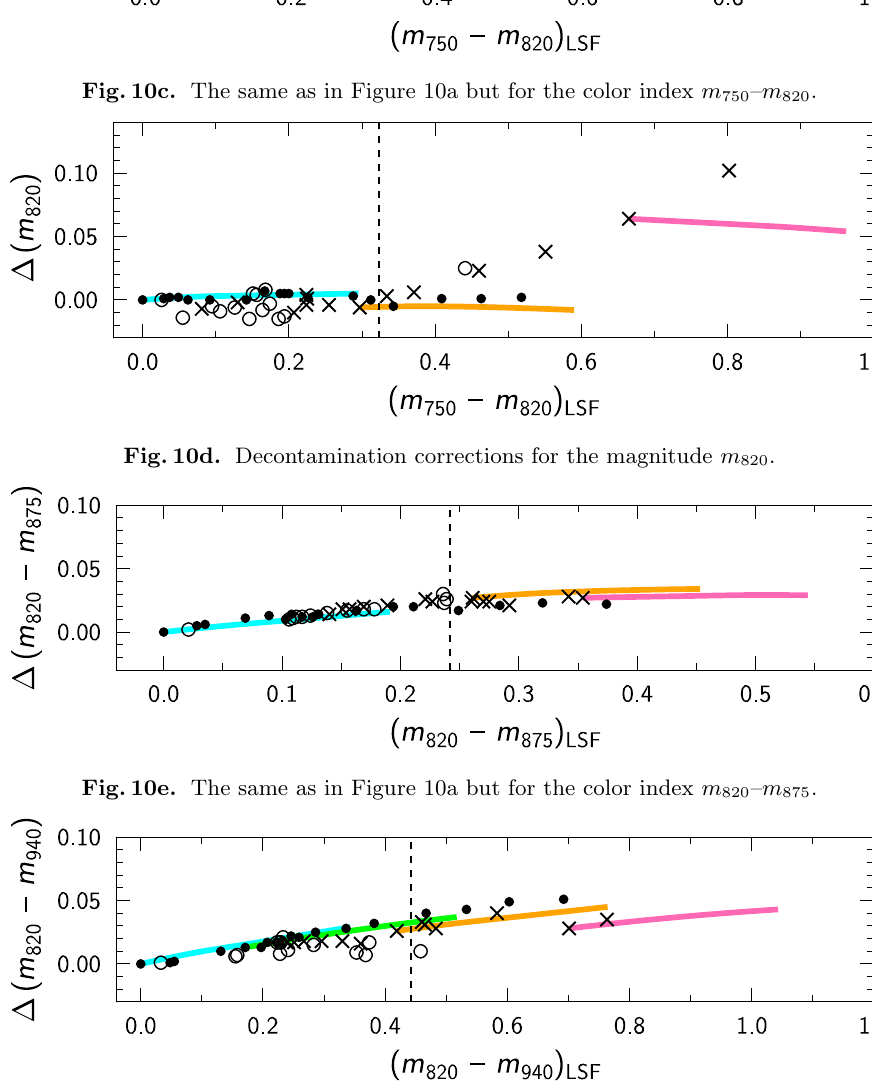
Fig. 10f. The same as in Figure 10a but for the color index m 820 – m 940